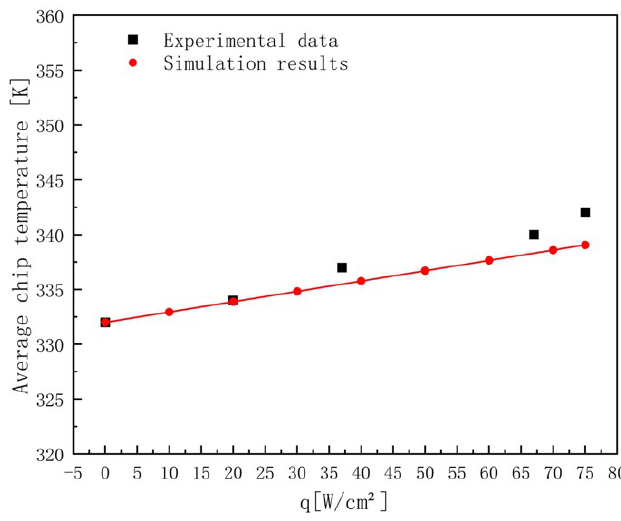
Figure 7. Simulation method validation.